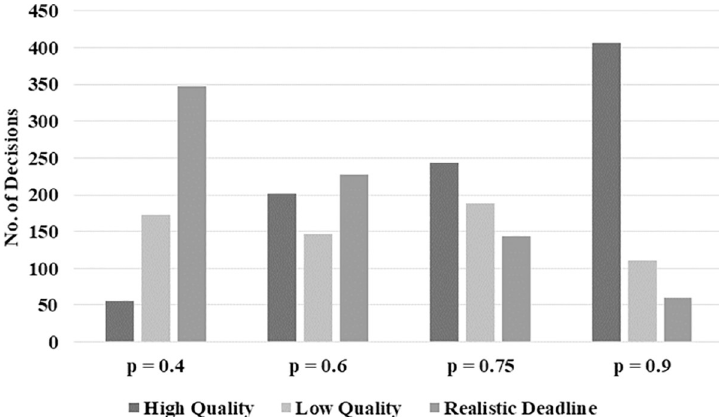
Fig 2. Distribution of unrealistic deadline (high-quality and low-quality decisions) and realistic deadline situations per treatment (n = 576).